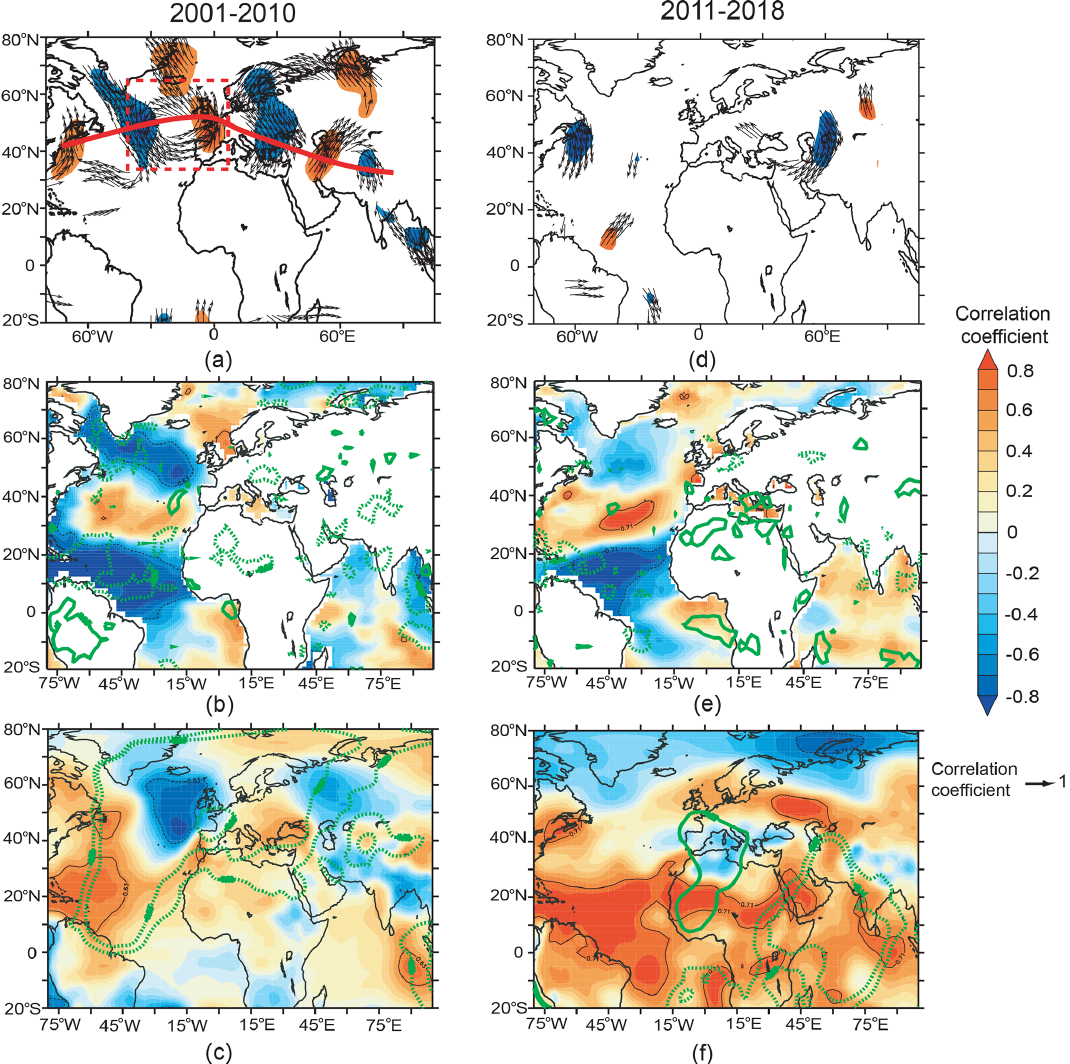
Figure 8. Correlation between the April–June North Atlantic difference index (NADI) and different meteorological parameters from the NCEP/NCAR Reanalysis averaged for May–September for (a–c) 2001–2010 and (d–f) 2011–2018. (a, d) Arrows show the correlation between the NADI and wind vectors averaged between the 500 and 200hPa pressure levels that are significant at the 95% confidence level. Red and blue shading highlight the regions where the meridional component of the wind has significant (at the 95% confidence level) positive and negative correlations with the NADI, respectively. (b, e) Shading shows the correlation between the NADI and SST, and the green contours enclose the regions where a significant correlation (at the 95% confidence level) exists between the NADI and precipitation. Black contours indicate the regions where the correlation between the NADI and SST is significant at the 95% confidence level. (c, f) Shading shows the correlation between the NADI and sea level pressure, and the green contours enclose the regions where a significant correlation exists between the NADI and velocity potential at the 850hPa pressure level: inner and outer contours indicate the 95% and 90% confidence levels, respectively. Black contours indicate the regions where the correlation between the NADI and sea level pressure is significant at the 95% confidence level. For all of the panels, solid and dashed contours are indicative of significant positive and negative correlations,